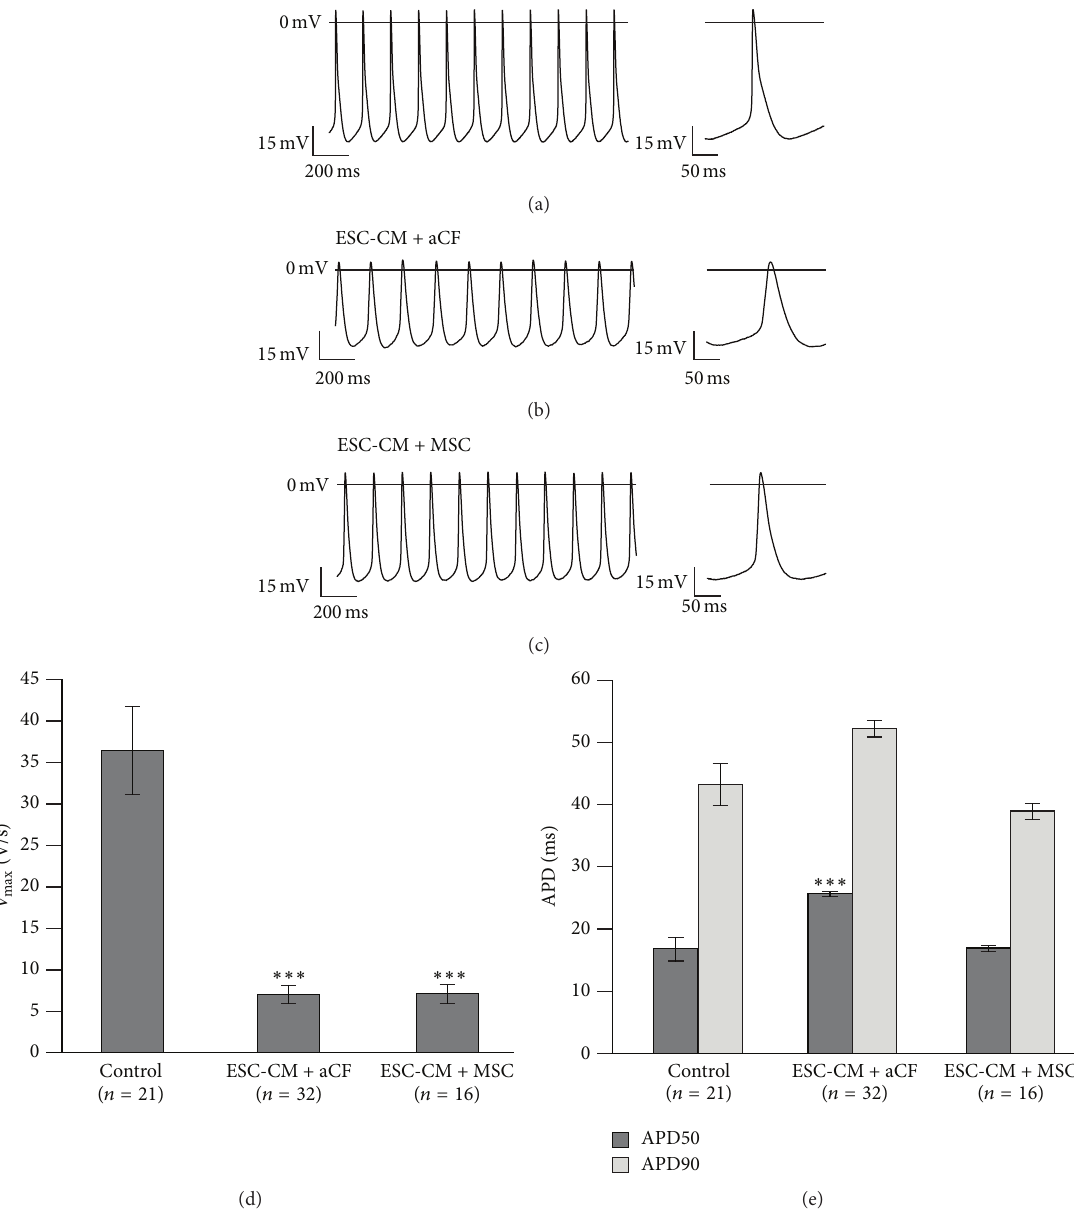
Figure 3: Comparison of action potential parameters of aCF-ESC-CM and MSC-ESC-CM cocultures as well as control ESC-CMs. Representative AP waveforms of beating clusters of ESC-CMs (a) as well as cocultures of ESC-CMs with aCFs (b) or with MSCs (c). Maximal upstroke velocity ( 𝑉 max ) was reduced in cocultures with aCFs and MSCs (d) while action potential duration was only prolonged in cocultures of ESC-CMs with aCFs (e) compared to controls. Data are expressed as mean ± SEM; ∗∗∗ 𝑝 < 0.001 .